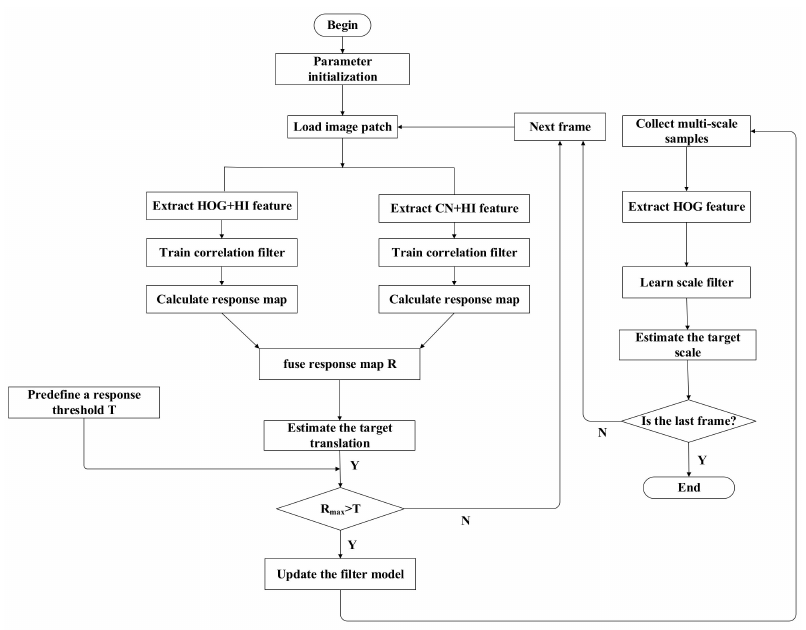
Figure 2. The overall framework of the proposed tracking